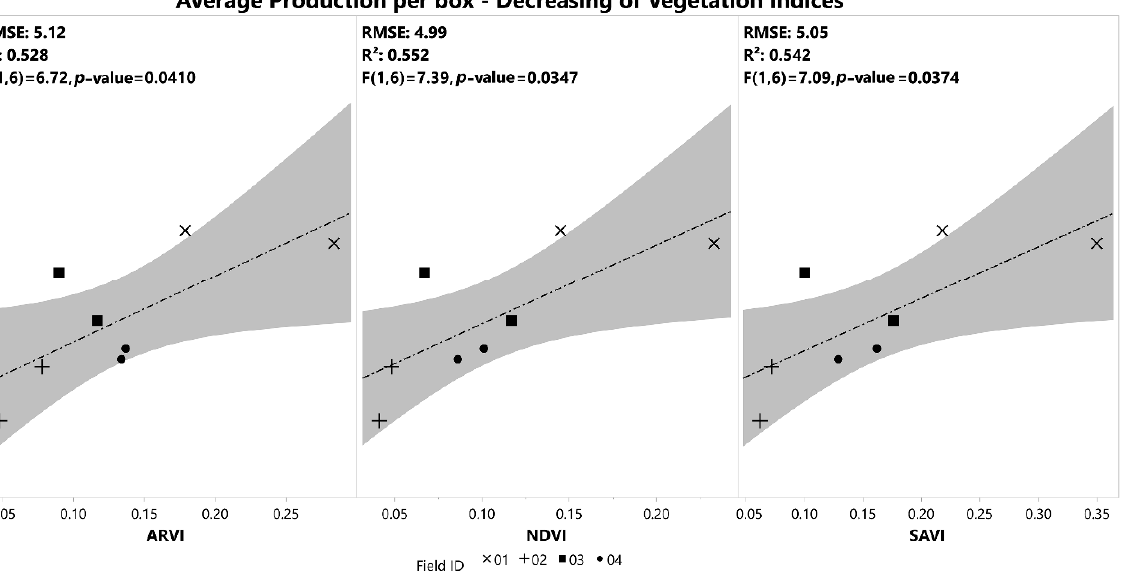
Figure 6. Average weight of cocoons [g] in relation to decreasing vegetation indices during the fifth instar of B. mori . Gray shaded areas represent the confidence interval of regression at 95%. 3.4.3. Average Weight of Silk Shell The determination coefficient R 2 values computed for the best-fitting regression lines were approximately 0.56 for the NDVI and SAVI. The regressions with decreasing NDVI